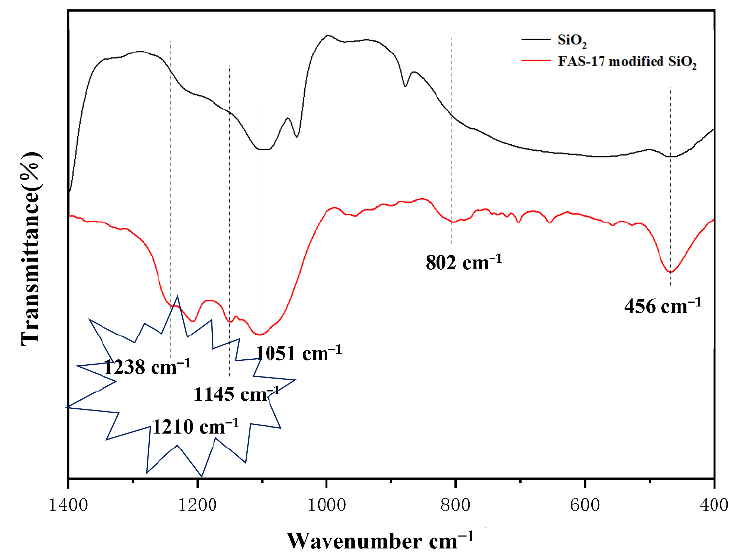
Figure 5. FT-IR spectra of SiO 2 and FAS-17-modified SiO 2.